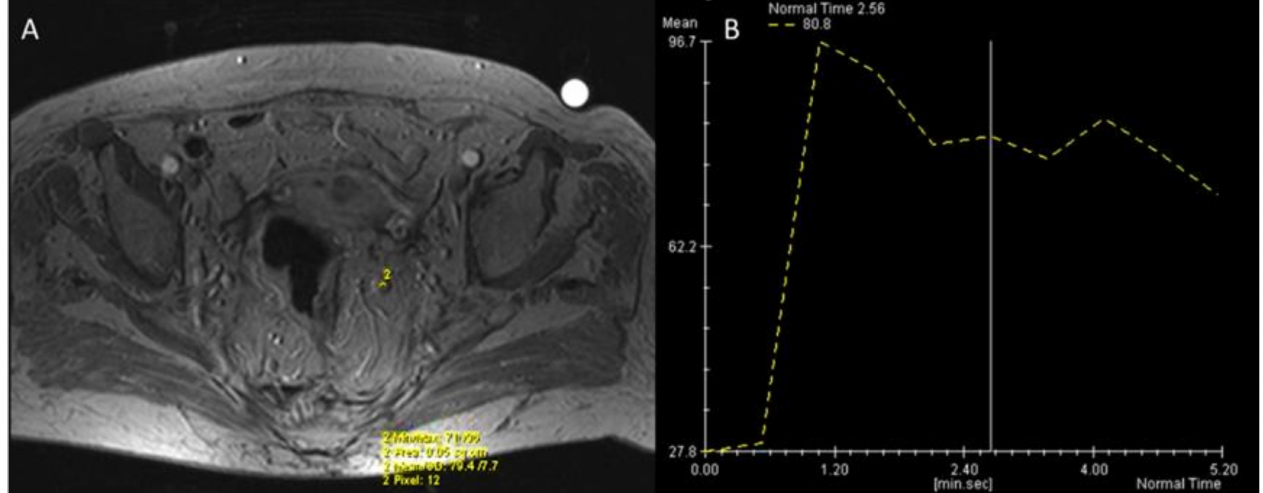
Figure 6. Woman 65 y.o. with rectal cancer (same patient of Figures 2 and 4). DCE- MRI ( A ) deposit assessment with Intensity/Time curve evaluation ( B ).